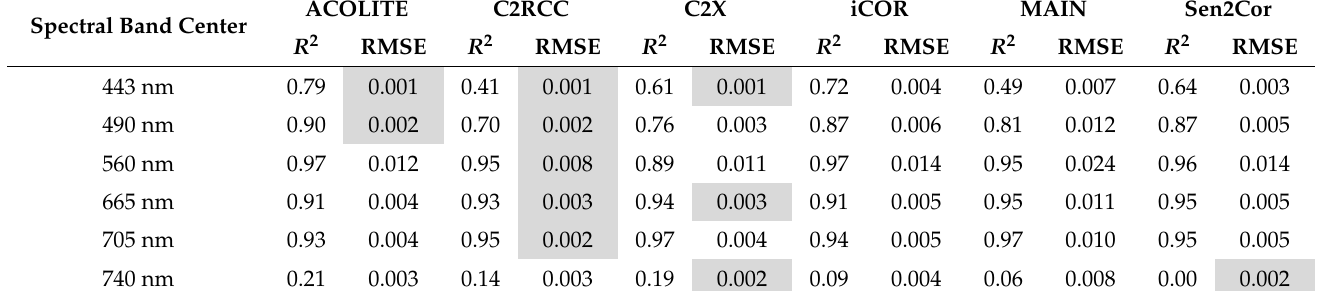
Table 5. Statistical metrics ( R 2 , RMSE) for six different atmospheric correction routines for Sentinel-2/MSI image (ACOLITE, C2RCC, C2X, iCOR, MAIN and Sen2Cor). Shaded areas indicate the lowest values of RMSE. Spectral Band Center